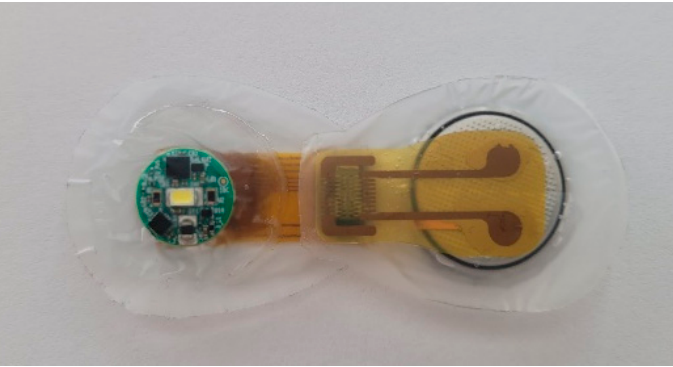
Figure 3. Encapsulated and connected sensor board and battery via Molex connector.